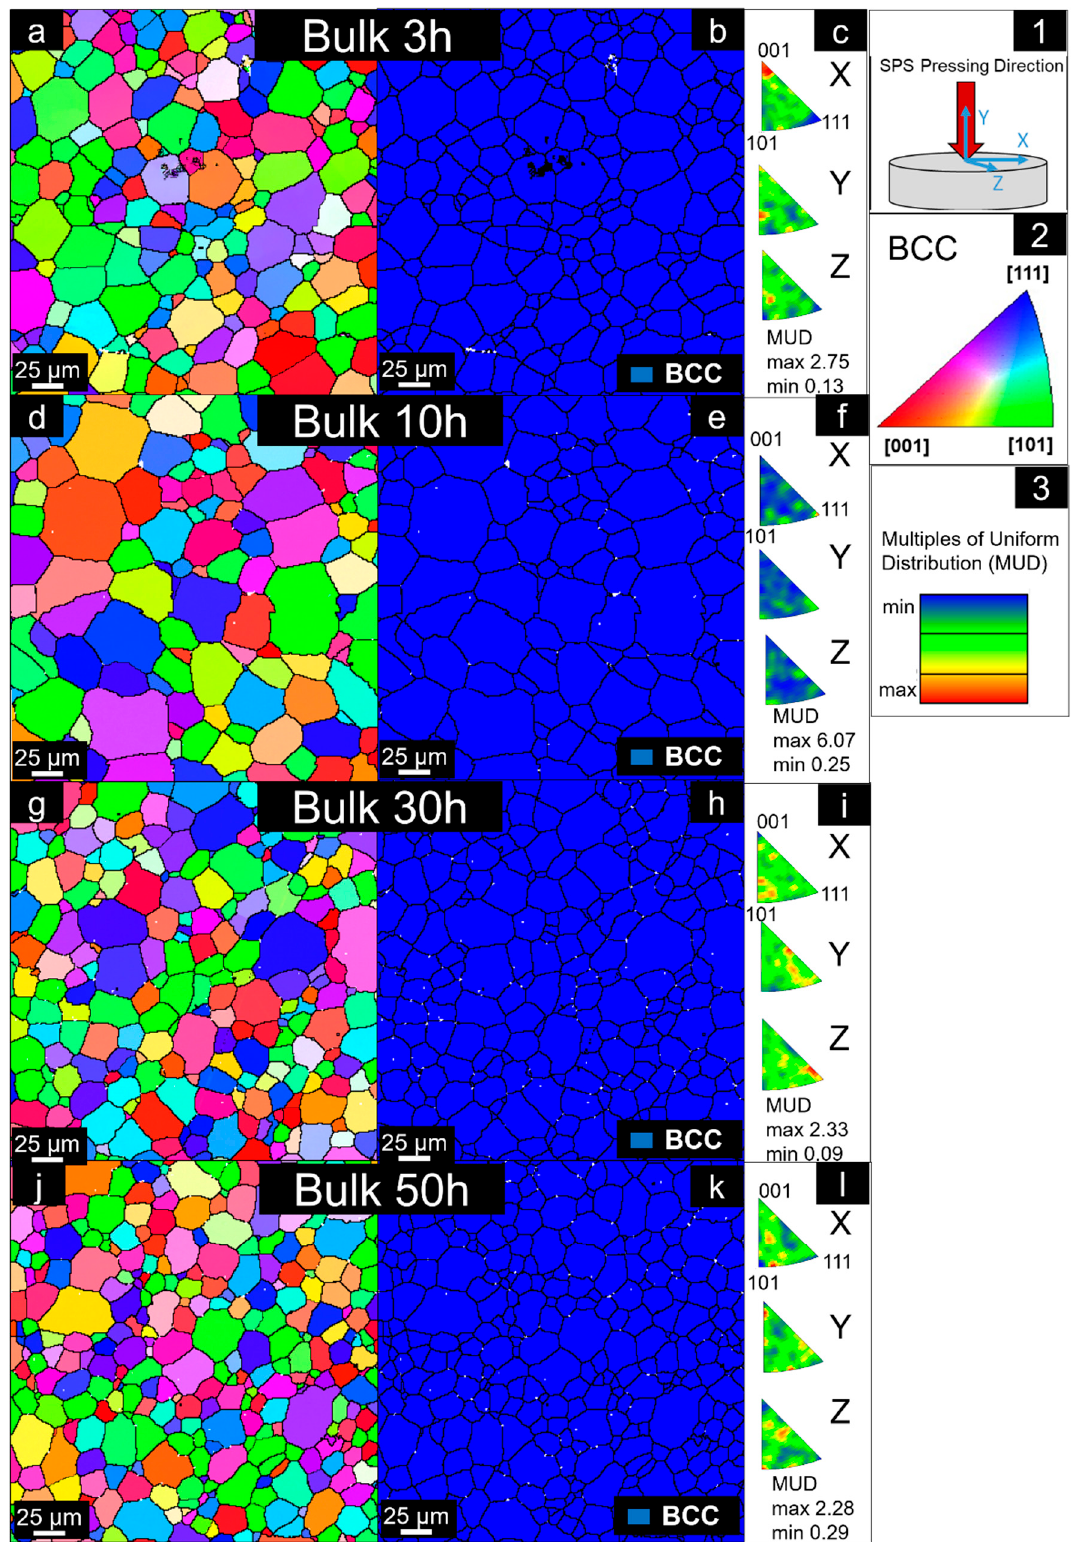
Figure 8. Representative EBSD results of Al 0.3 NbTa 0.8 Ti 1.5 V 0.2 Zr sintered bulks subject to different powder milling times. ( a , d , g , j ) Inverse pole figure showing grain orientation maps with reference direction perpendicular to the SPS compaction direction denoted as Z in ( 1 ), for 3, 10, 30 and 50 h, respectively. The colors represent the directions shown in ( 2 ). ( b , e , h , k ) Phase map showing distribution of BCC grains (white regions represent dispersed oxides), for 3, 10, 30 and 50 h, respectively. ( c , f , i , l ) Inverse pole figures of BCC phase. MUD reference is shown in ( 3 ).